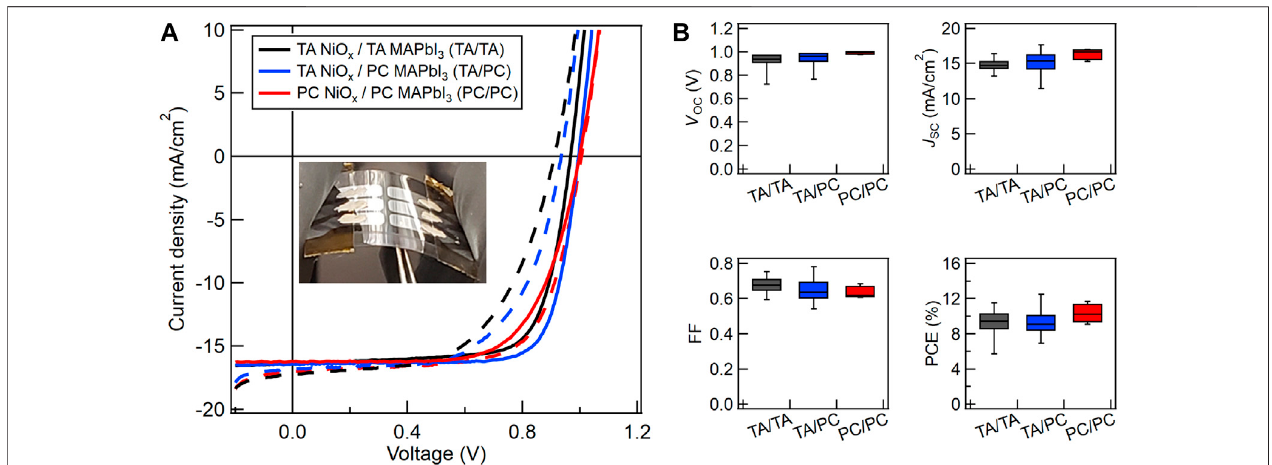
FIGURE 2 | (A) Champion reverse (solid) and forward-scan (dashed) device J-V curves for PSCs on WG/ITO fabricated with TA NiO x + TA MAPbI 3 (TA/TA, black), TANiO x +PCMAPbI 3 (TA/PC,blue),orPCNiO x +PCMAPbI 3 (PC/PC,red).PCNiO x wasfabricatedat500 Vlampvoltage,10 mspulselength,and10pulsesat0.2 Hz. The inset is a photograph of a fl exible WG PSC device. (B) Box plots of V OC , J SC , FF, and PCE variation measured in reverse-scan for PSCs made with the same conditions listed in (A)